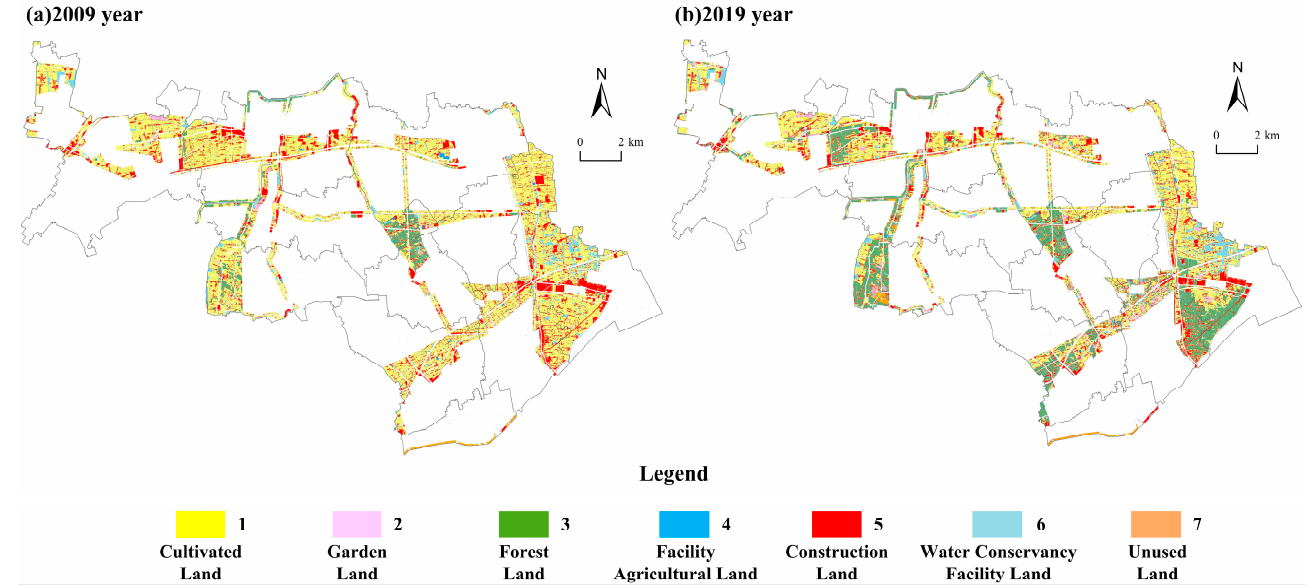
Figure 3. Land use status in 2009 and 2019. (Note: Nos. 1–7 represent cultivated land, garden land, forest land, facility agricultural land, construction land, water conservancy facility land, and unused land.)